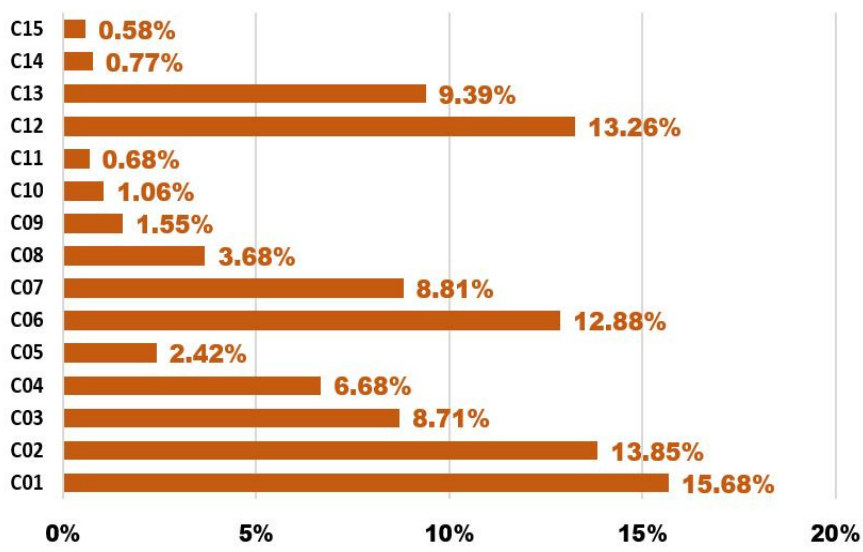
Figure 5. Percentage of presence by type of cause.